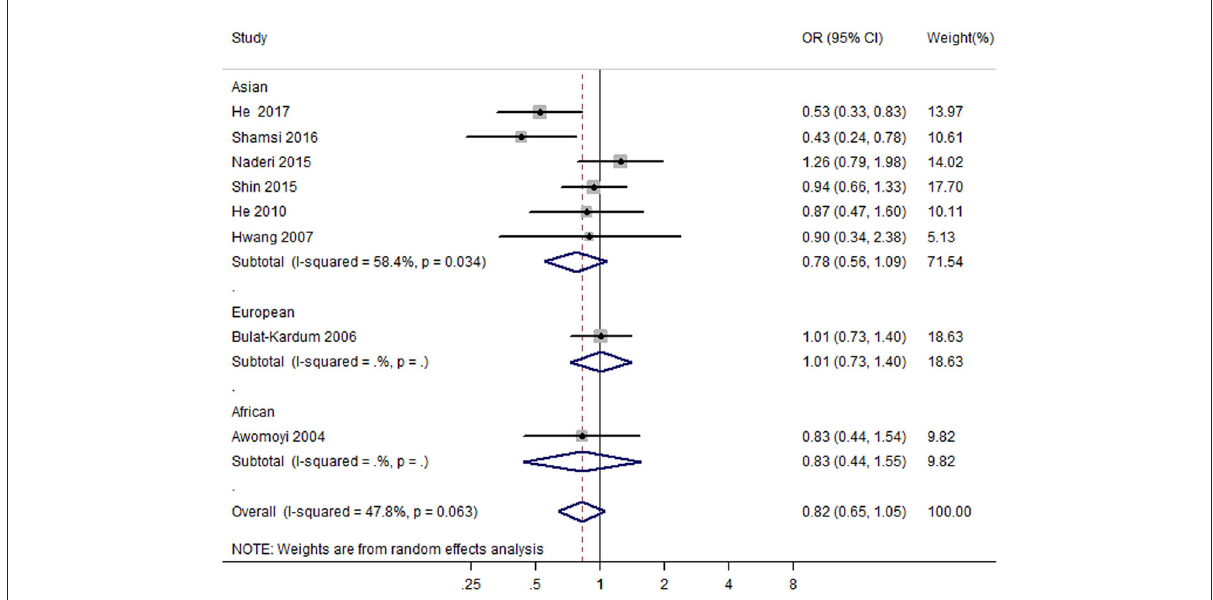
FIGURE3 Forest plot of association between IFNGR1 rs1327474 polymorphism and tuberculosis susceptibility (dominant model: GG + AG vs. AA).